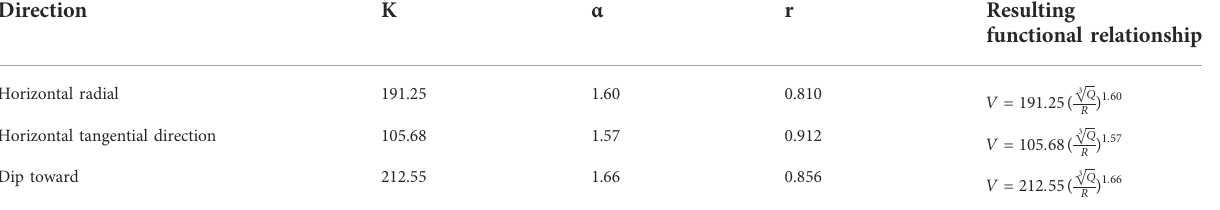
TABLE 4 Results of regression analysis of measured vibration speed.